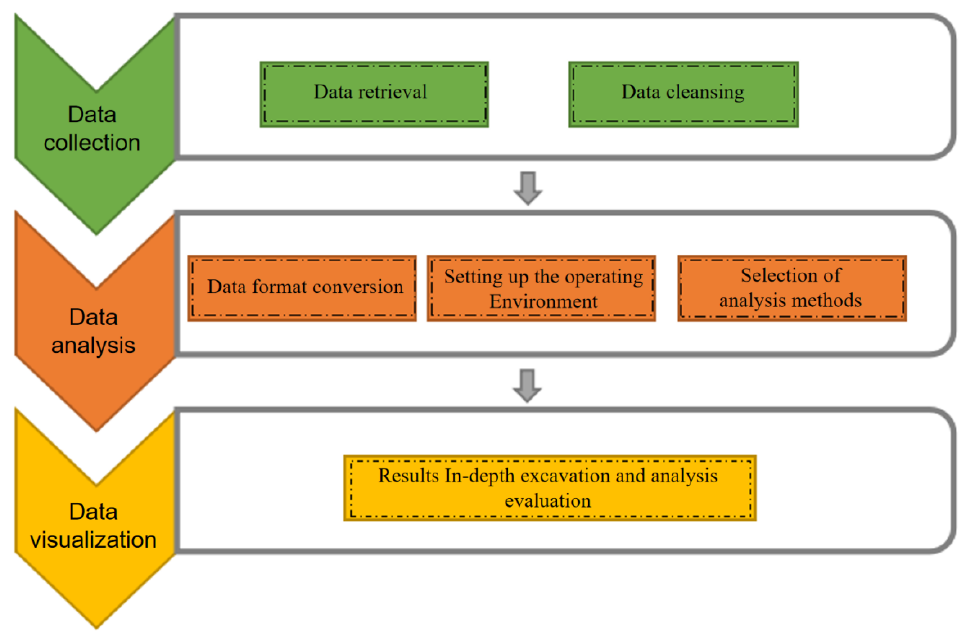
Figure 1. Workflow of the Bibliometrix software bibliometric analysis.